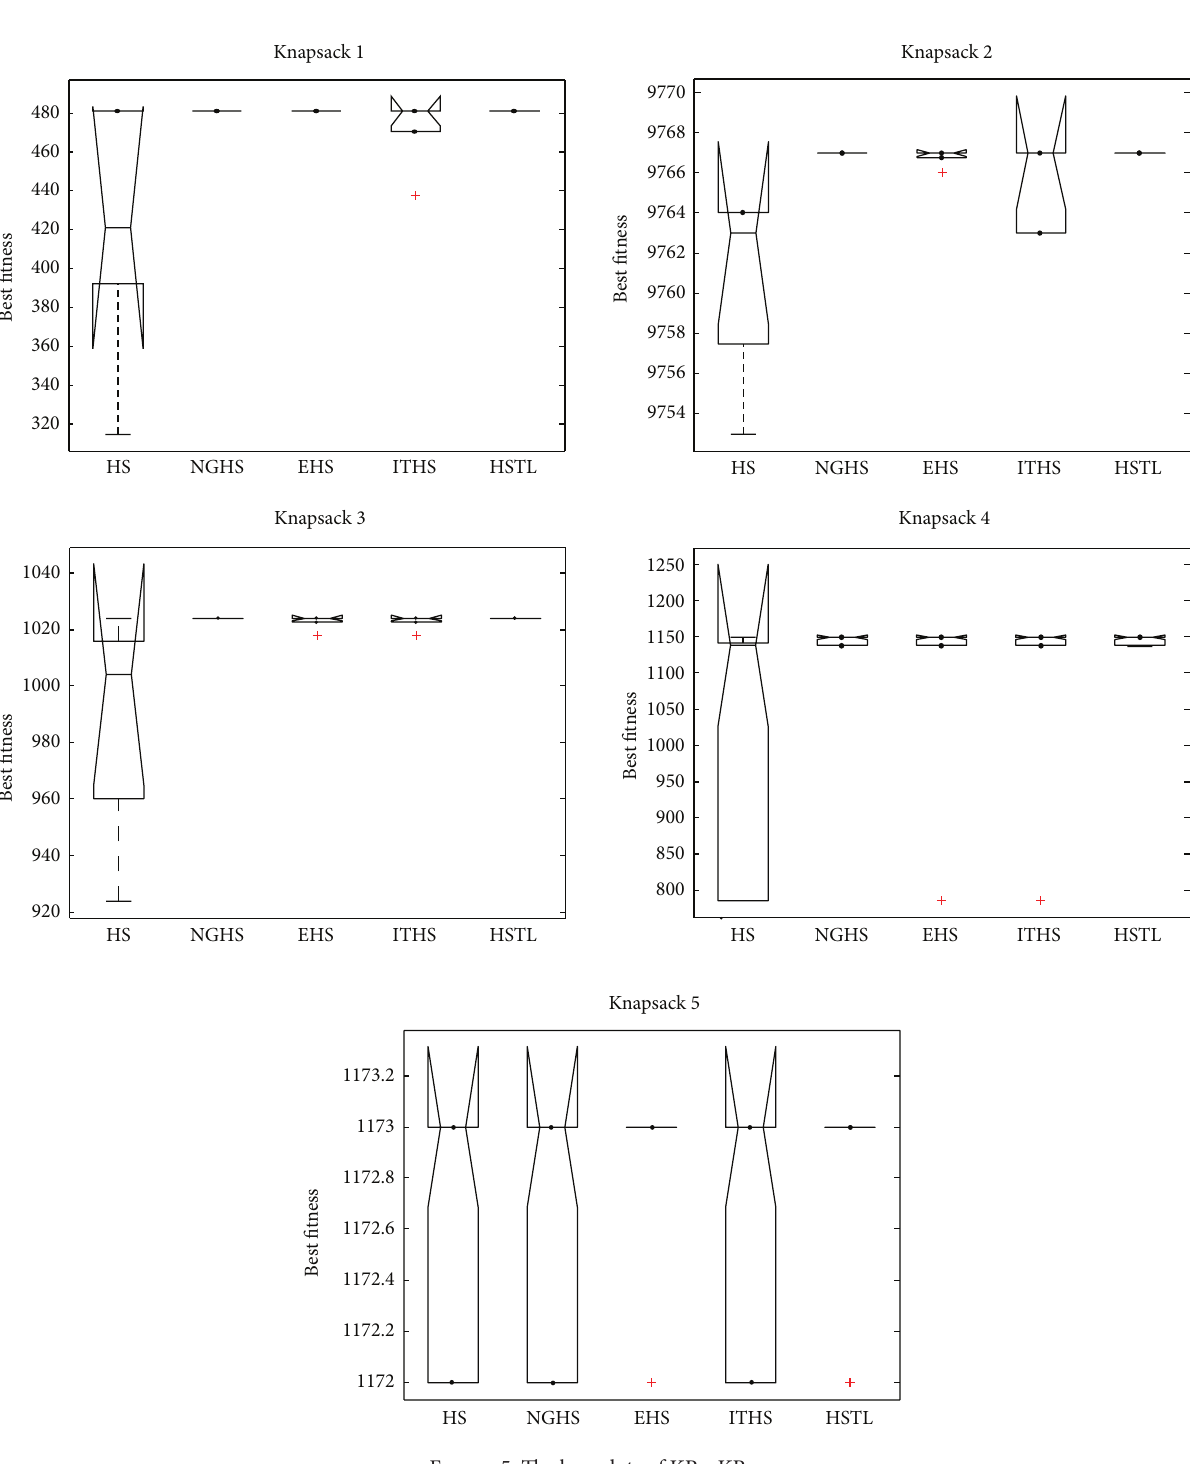
Figure 5: The box plots of KP 1 –KP 5